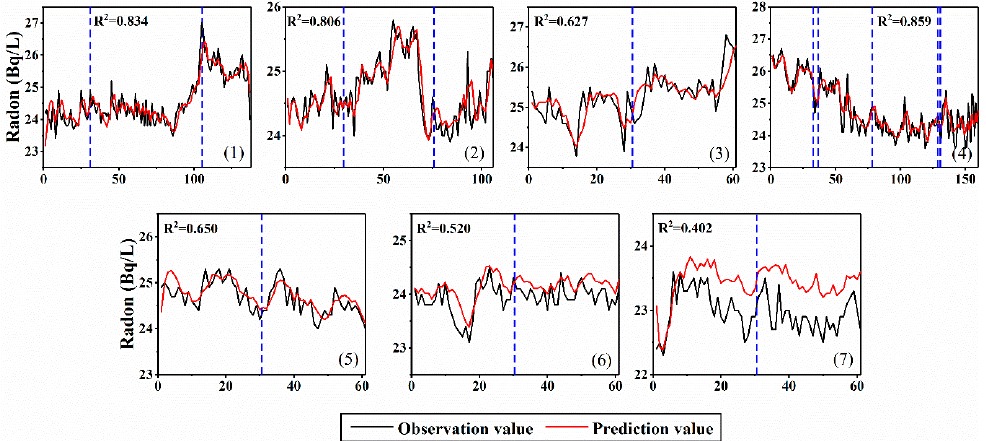
Figure 7. The predicted results during the seismic activity period, and the correlation coefficient R 2 between the observation and the prediction values. The number (1)–(7) represent the 7 seismic activity periods. The blue dotted line represents the time of the earthquake occurrence.